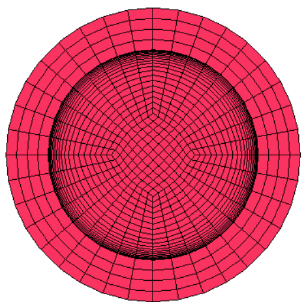
Figure 2. Generation mesh in the computational domain. Table 1. The grid settings.